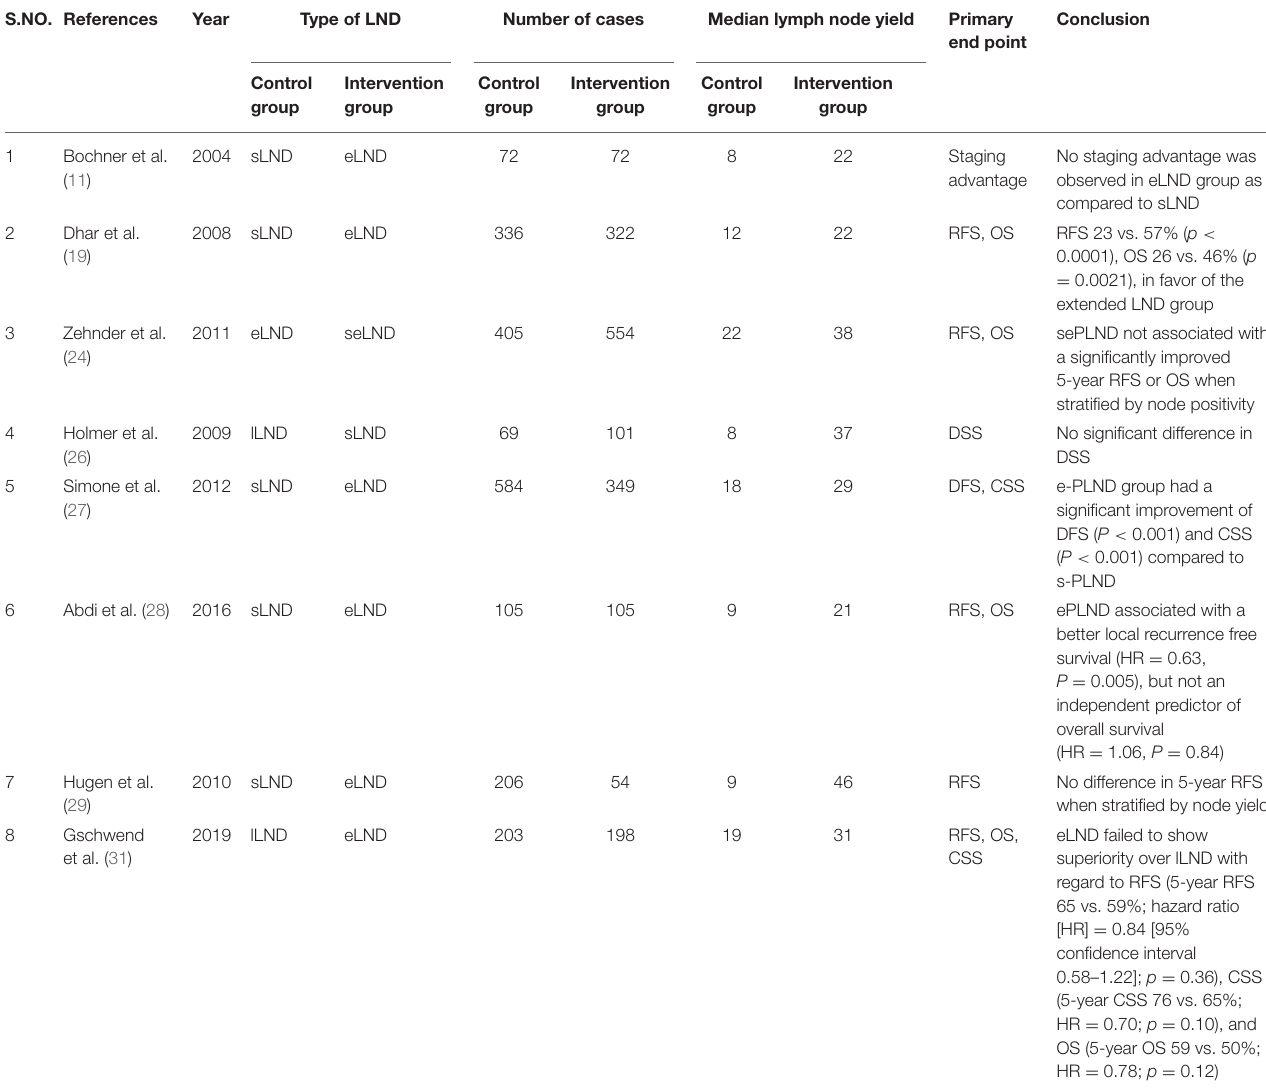
TABLE 3 | Comparison of lymph node yield in different PLND templates in various studies.